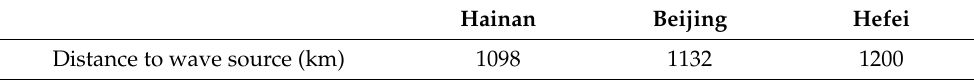
Table 2. The calculated distances between the observed site and wave source. Hainan Beijing Hefei Figure 4. Diagram of evaluated GW source position located at the edge of TP. Distance to wave source (km) 1098 1132